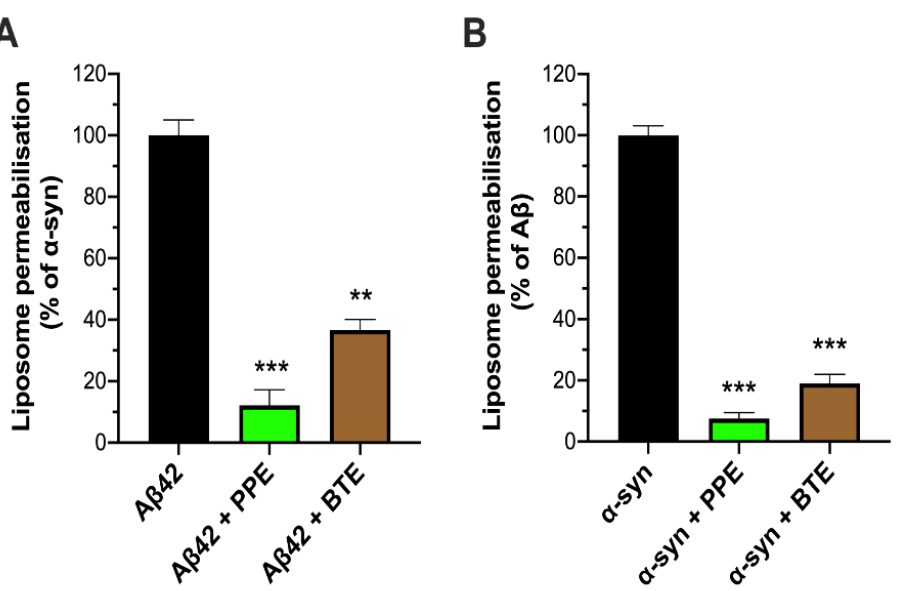
Figure 3. Inhibition of mito-mimetic lipid vesicle permeabilization. Padina pavonica extract (PPE; 1 μg/mL), black tea extract (BTE; 1 μg/mL) or 0.01% DMSO (solvent control) were incubated with ( A ) 1 μM Aβ42 or ( B ) 0.5 μM α -syn oligomeric preparation at RT for 10 min, before adding to 60